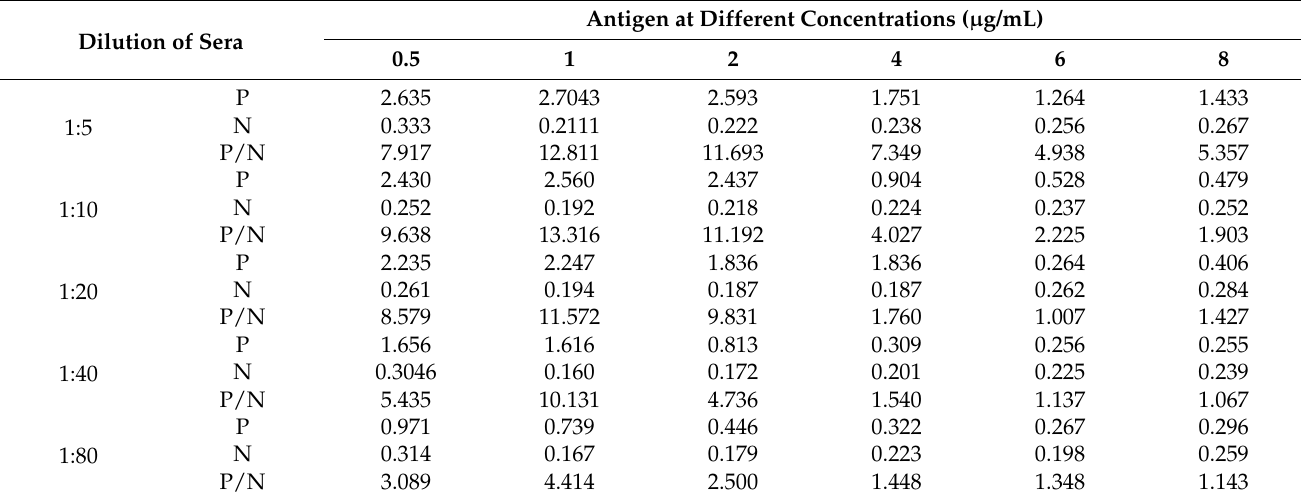
Table 1. Determination of optimal antigen coating concentration and serum